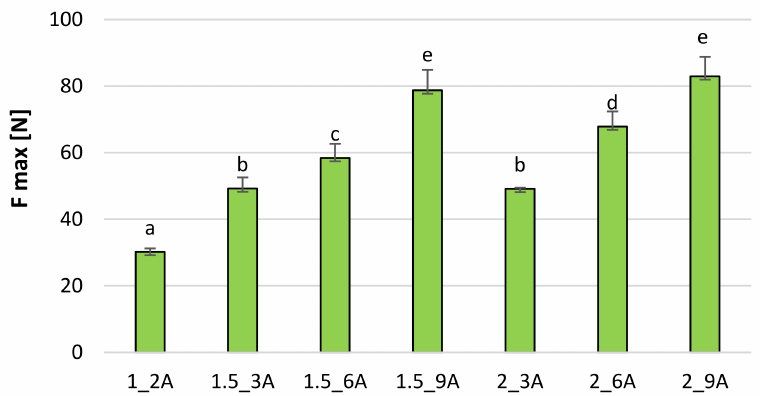
Figure 6. The maximum cutting force [N] of freeze-dried fruit bars with apple pomace. Mean values marked with the same index letter (a–e) do not differ statistically significantly at the level of p = 0.05. Denotations in Table 1 include Index (A) next to the sample symbol—bars with the apple pomace.